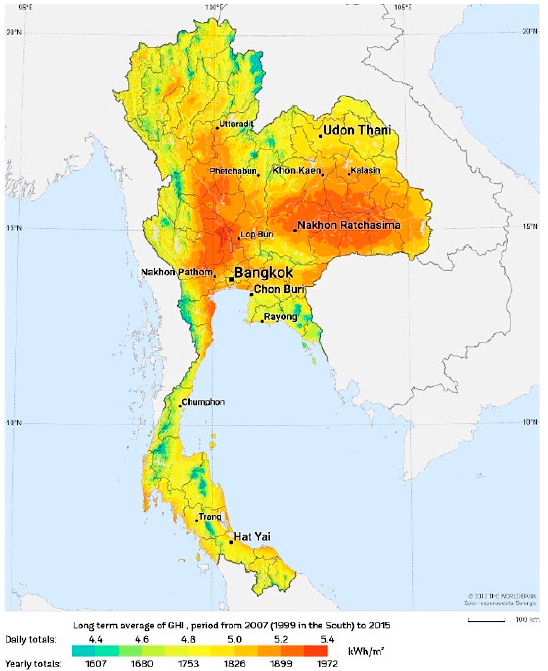
Figure 2. The average daily solar radiation intensity in Thailand [23].